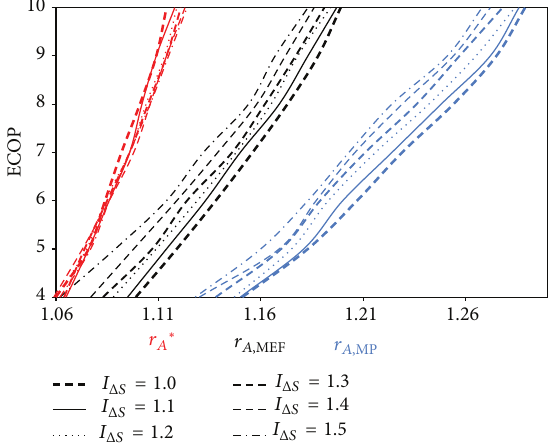
̇𝐸 ̇𝑊 , , and circumstances MAX MAX MAX